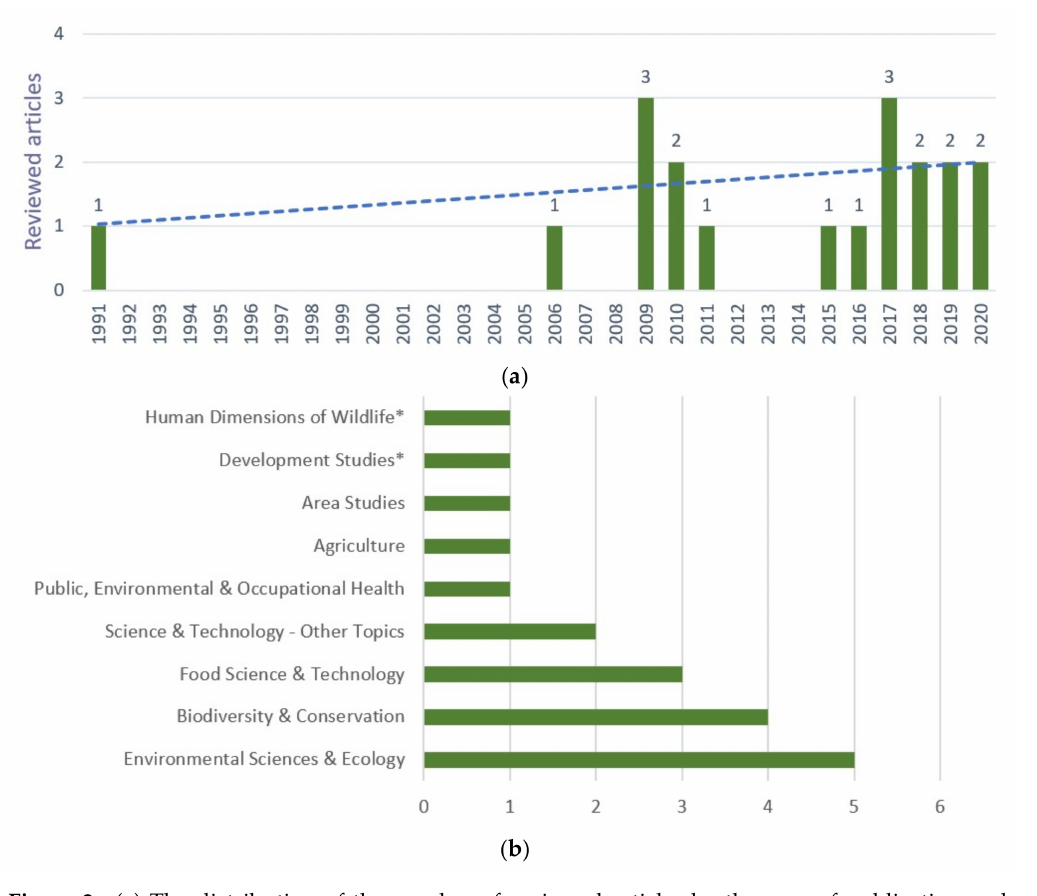
Figure 2. ( a ) The distribution of the number of reviewed articles by the year of publication and ( b ) primary research domains of reviewed